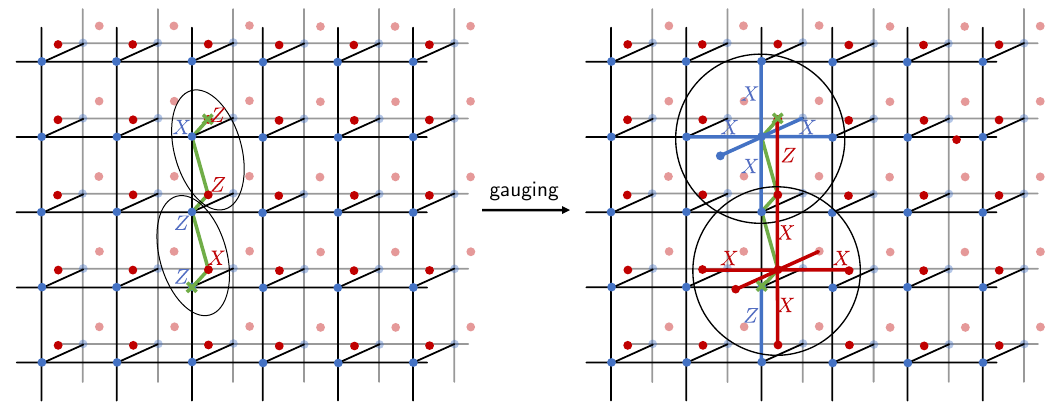
Figure 31: Left: On the background of the 3d paramagnetic Ising model, a 1d clus- ter state is decorated on an open string (green line) terminated at two point defects (green crosses). The single-body paramagnetic Ising term X ν is removed on the blue or red site coinciding with the green crosses. Right: After gauging the (cid:90) metry, the vertex X -stabilizer on the green line (between the endpoints) is dressed with an additional Z of a different color. The 6-body vertex X -stabilizers centered on the blue or red vertices coinciding with the green crosses are